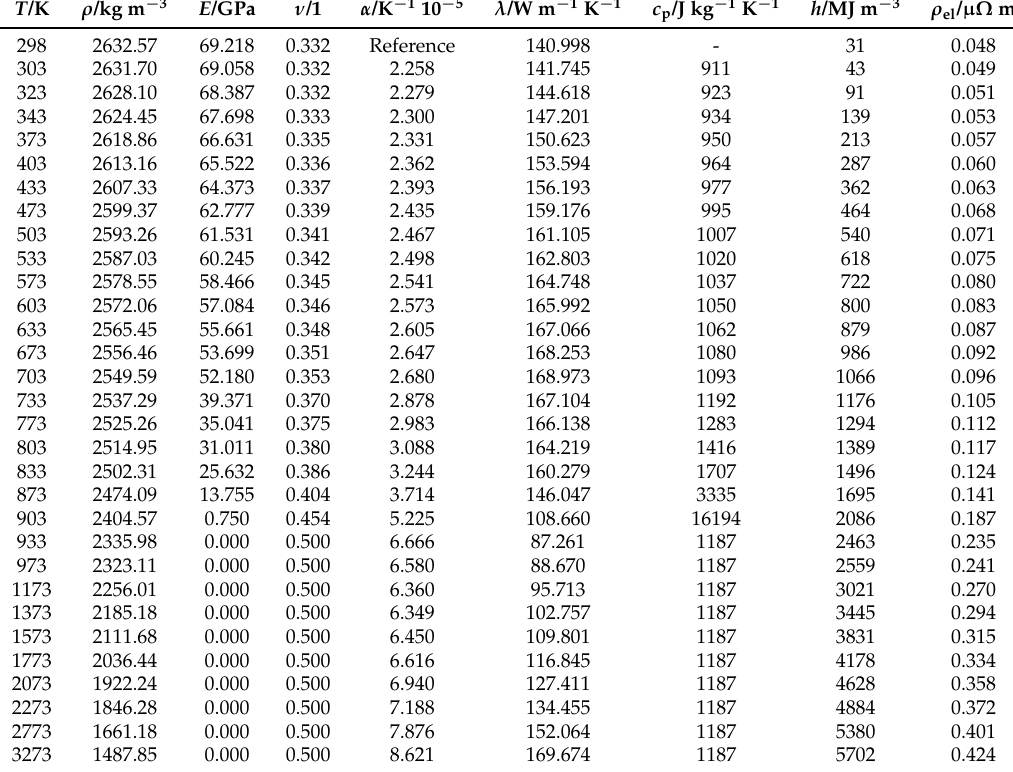
Table A2. Thermophysical properties of EN-AW-5083.